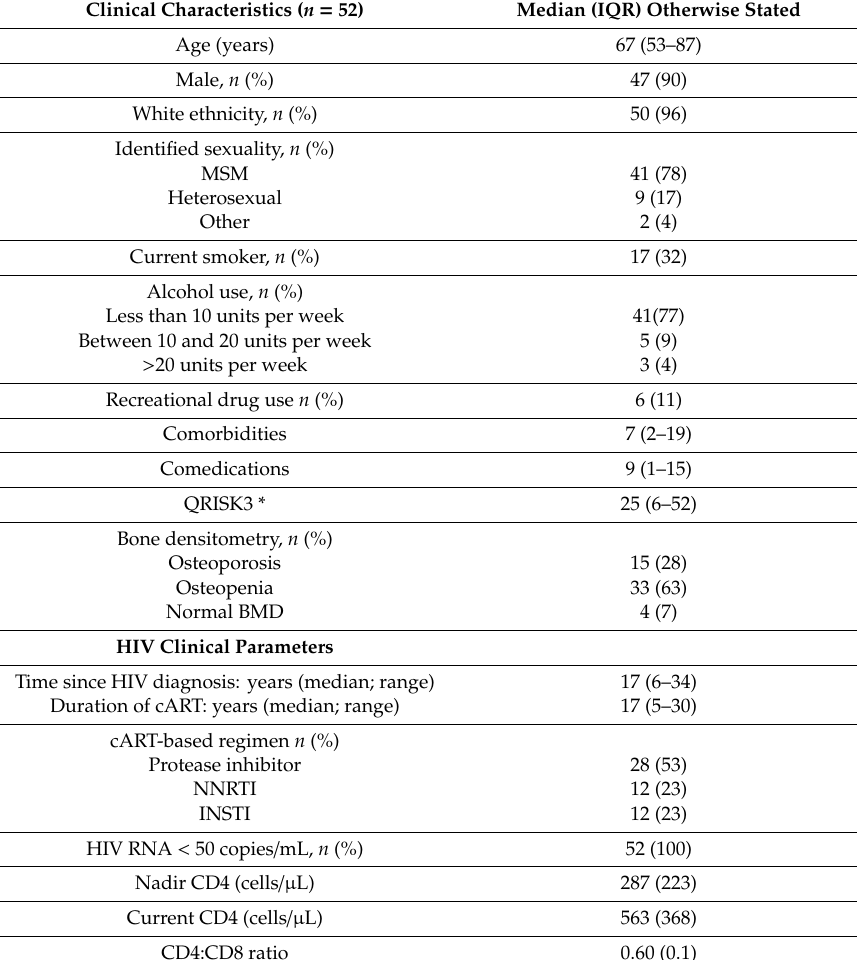
Table 2. Summary of patient